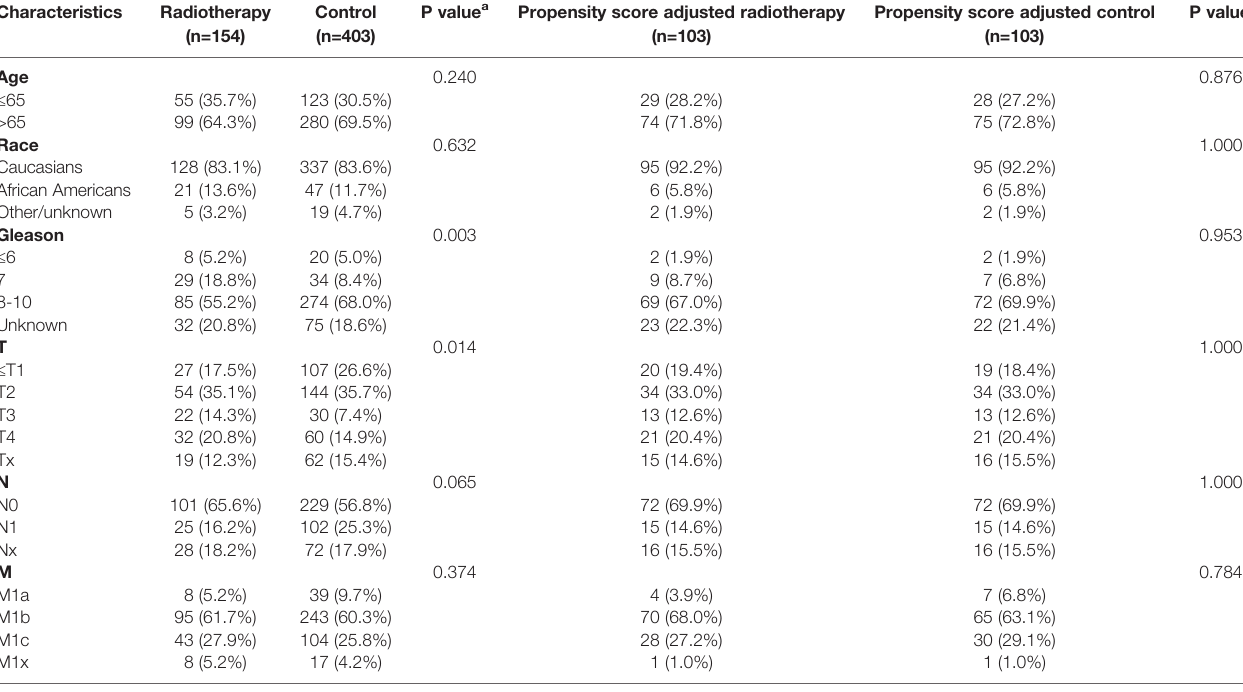
TABLE 3 | Clinicopathological characteristics of the PSA <4 ng/ml subgroup strati fi ed according to treatment modality with and without propensity score matching. Characteristics